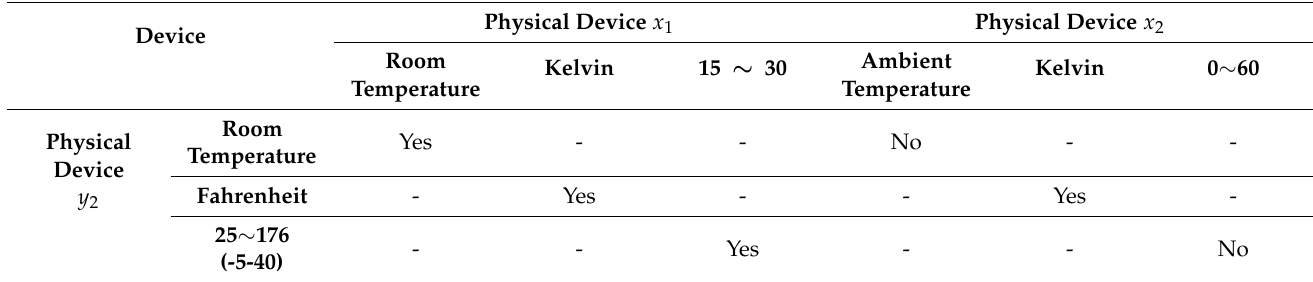
Table 3. Compatibility check result between input/output of physical